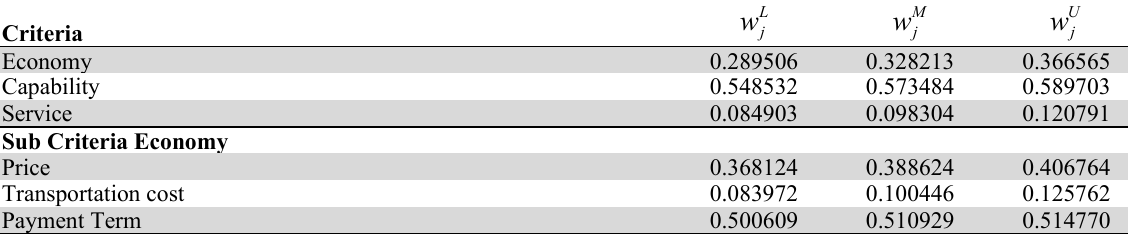
Priority Vectors Resulted by the Fuzzy LLSM Model